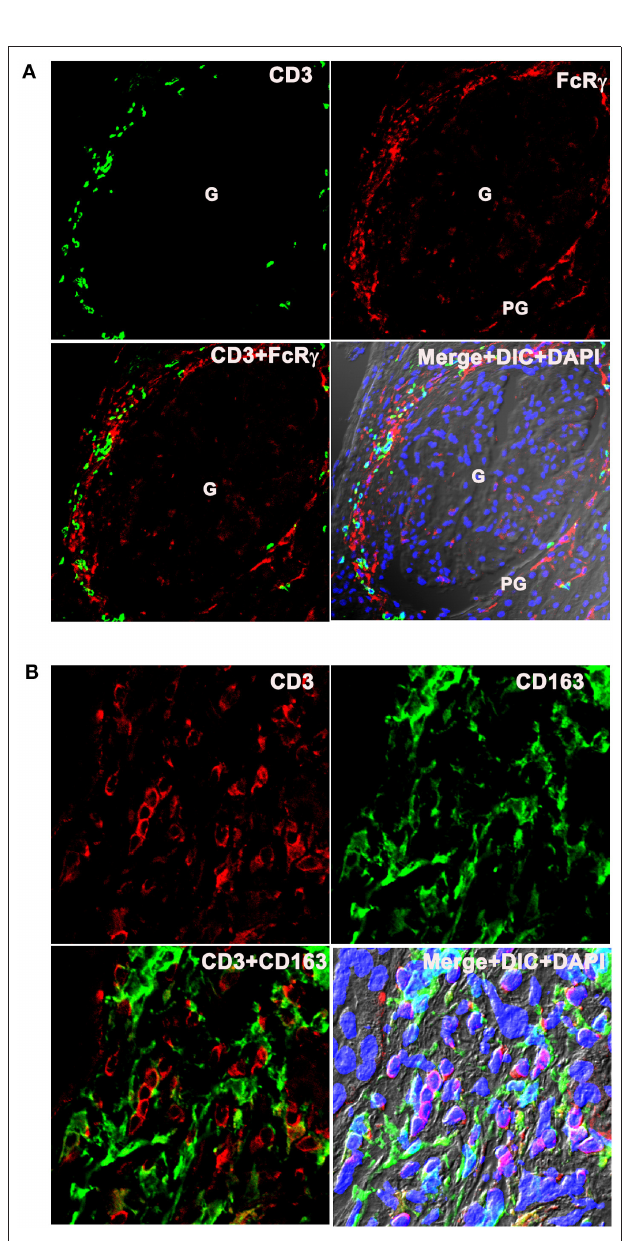
FIGURE 7 | Inflammatory dendritic cells are present in close proximity with T cells at LN flare. (A) The top row portrays 3 color IF images that represents three LN kidneys showing the presence of CD3 (Pan T cell marker in green) next to FcR γ (infDC marker in red). The bottom row portrays the merged images of the first 2 columns in the right and merged images of the first 2 columns plus DIC and DAPI staining of nuclei (blue) in the left. (B) The top